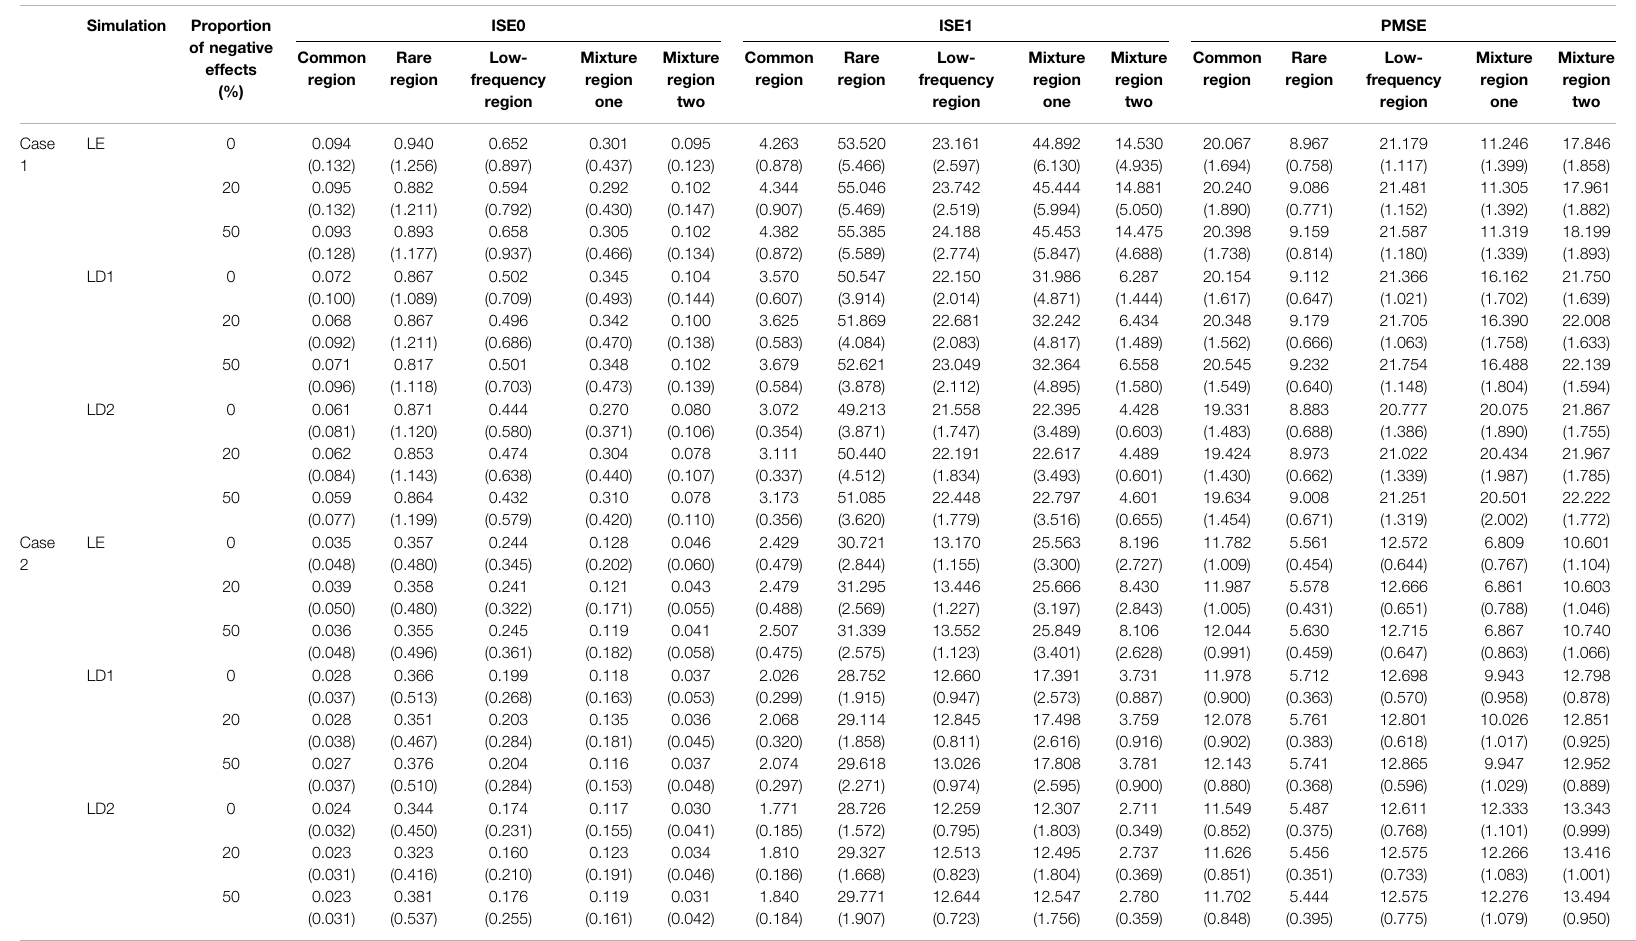
TABLE9| Comparetheestimatedmeansandstandarderrors(intheparenthesis)ofthreeindicatorsforlinkageequilibriumandlinkagedisequilibriumsimulationbasedonLFDAmethodwhensamplesizeis1,500, c is5,and proportion of casual variants is